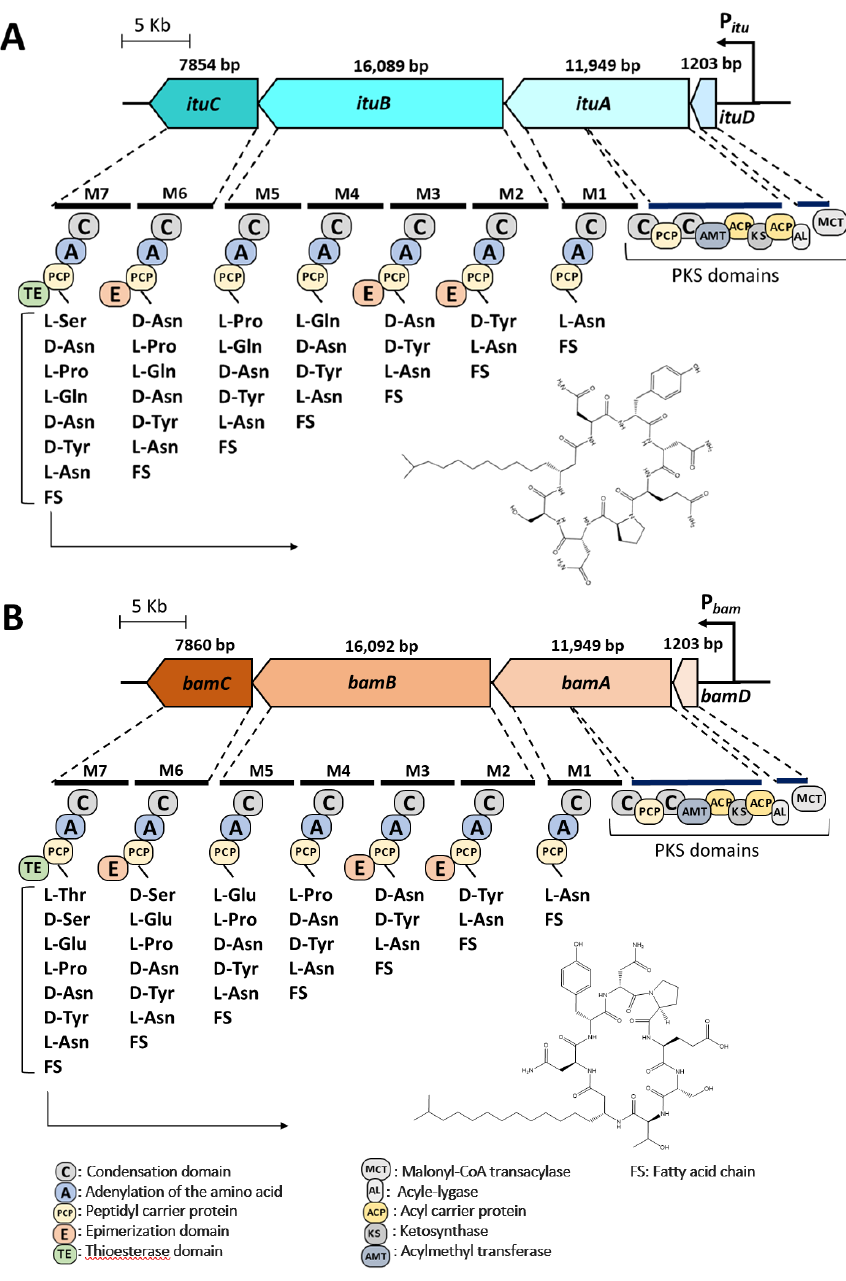
Figure 1. Genomic organization and modulation of the NRPSs producing bacillomycin D and iturin A. ( A ) Iturin A operon in B. velezensis UTB96 contains four ORFs of ituD , ituA , ituB , and ituC (37,246 bp), ( B ) Bacillomycin D operon in B. velezensis FZB42 contains four ORFs of bamD, bamA, bamB , and bamC (37,251 bp) [17]. The organization of the modules is comparable in both operons, although modules 4–7 catalyze different amino acids for the integration into the peptide